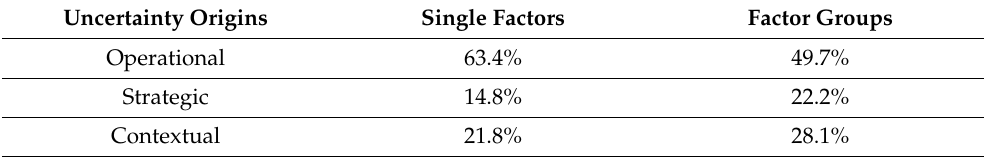
Table 3. Comparing origins of uncertainty based on a single-factor level and a factor group